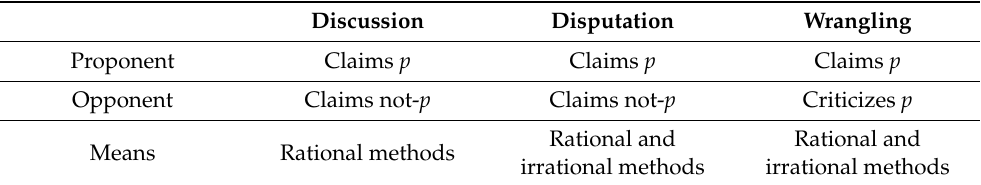
Table 1. Categories of